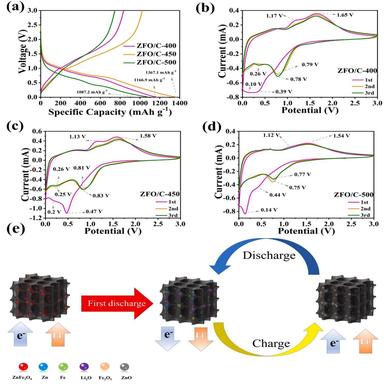
(a) First charge-discharge curves of the prepared electrodes; CV curves of (b) ZFO/C-400, (c) ZFO/C-450, and (d) ZFO/C-500 at a scanning rate of 0.1 mV s–1; (e) Schematic diagram of electrochemical reactions in charge-discharge process.